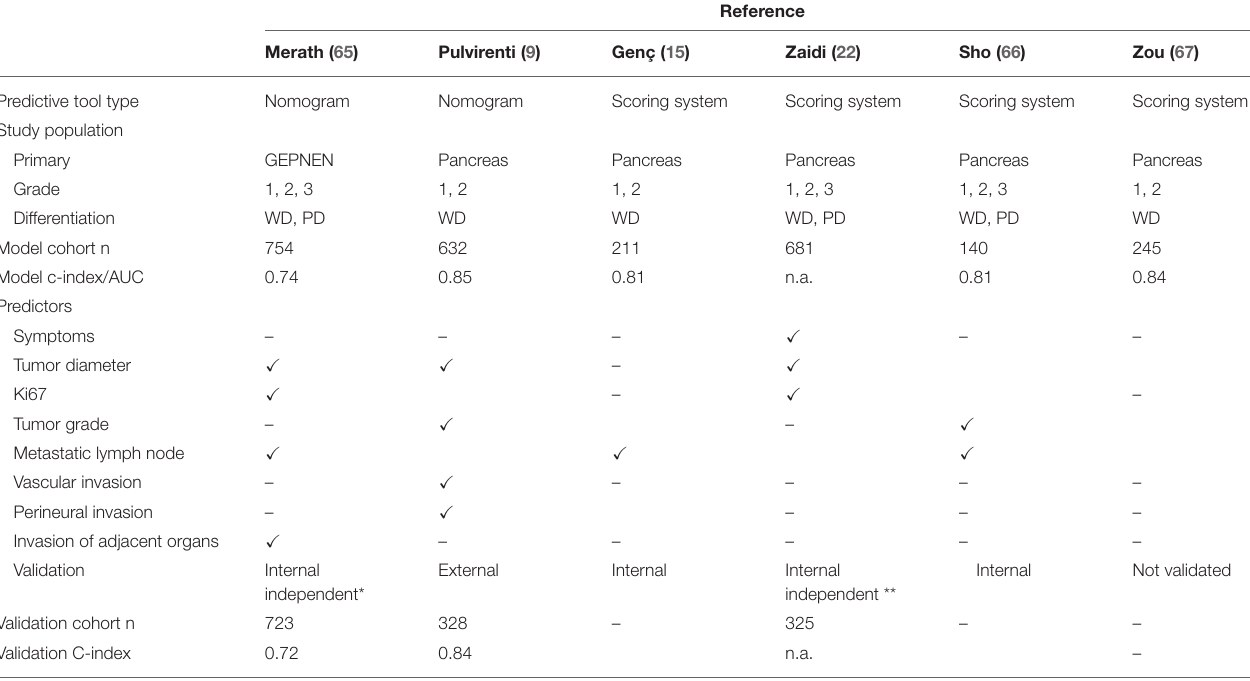
TABLE 2 | Summary of predictive